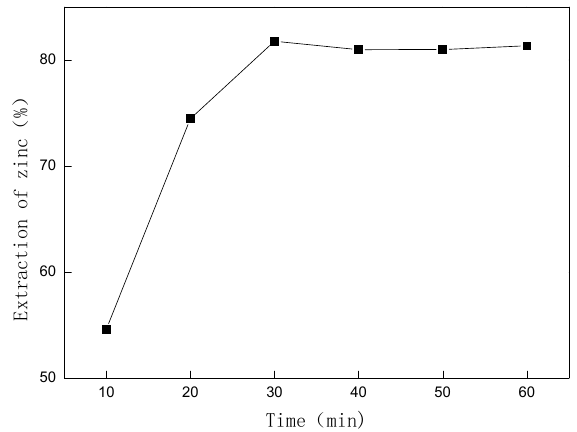
Figure 9. Effect of time (Concentrations of ammonia and ammonium chloride, 2.5 mol/L and 5 mol/L, respectively, L/S 6 mL/g, temperature 40 °C).